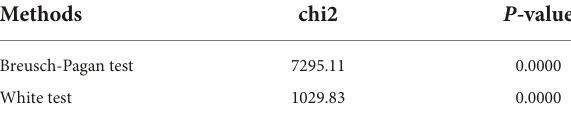
TABLE 2 Heteroskedasticity tests.